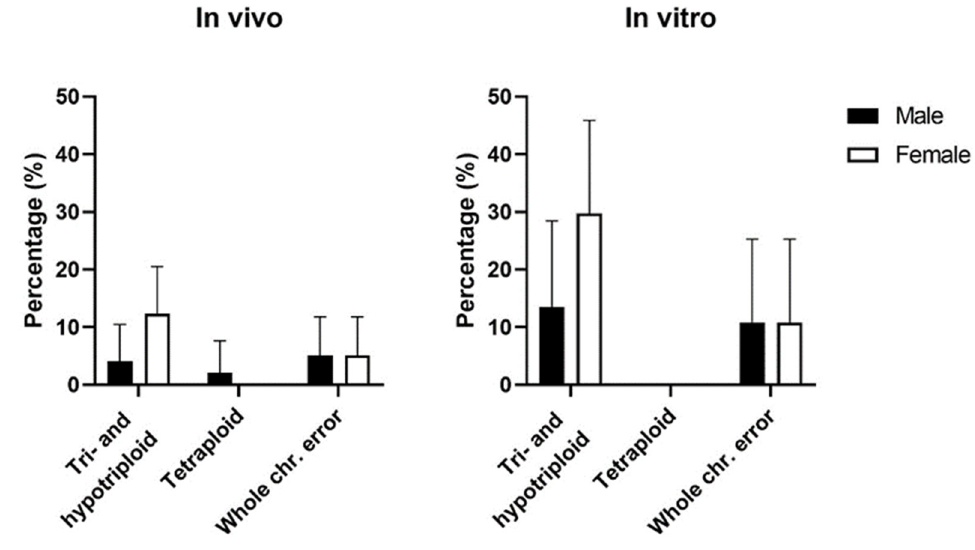
Figure 7. Incidence of chromosome errors based on sex for in vivo-derived embryos ( n = 97) and in vitro-produced blastocysts ( n = 37) excluding haploid, parthenogenetic, and androgenetic embryos.